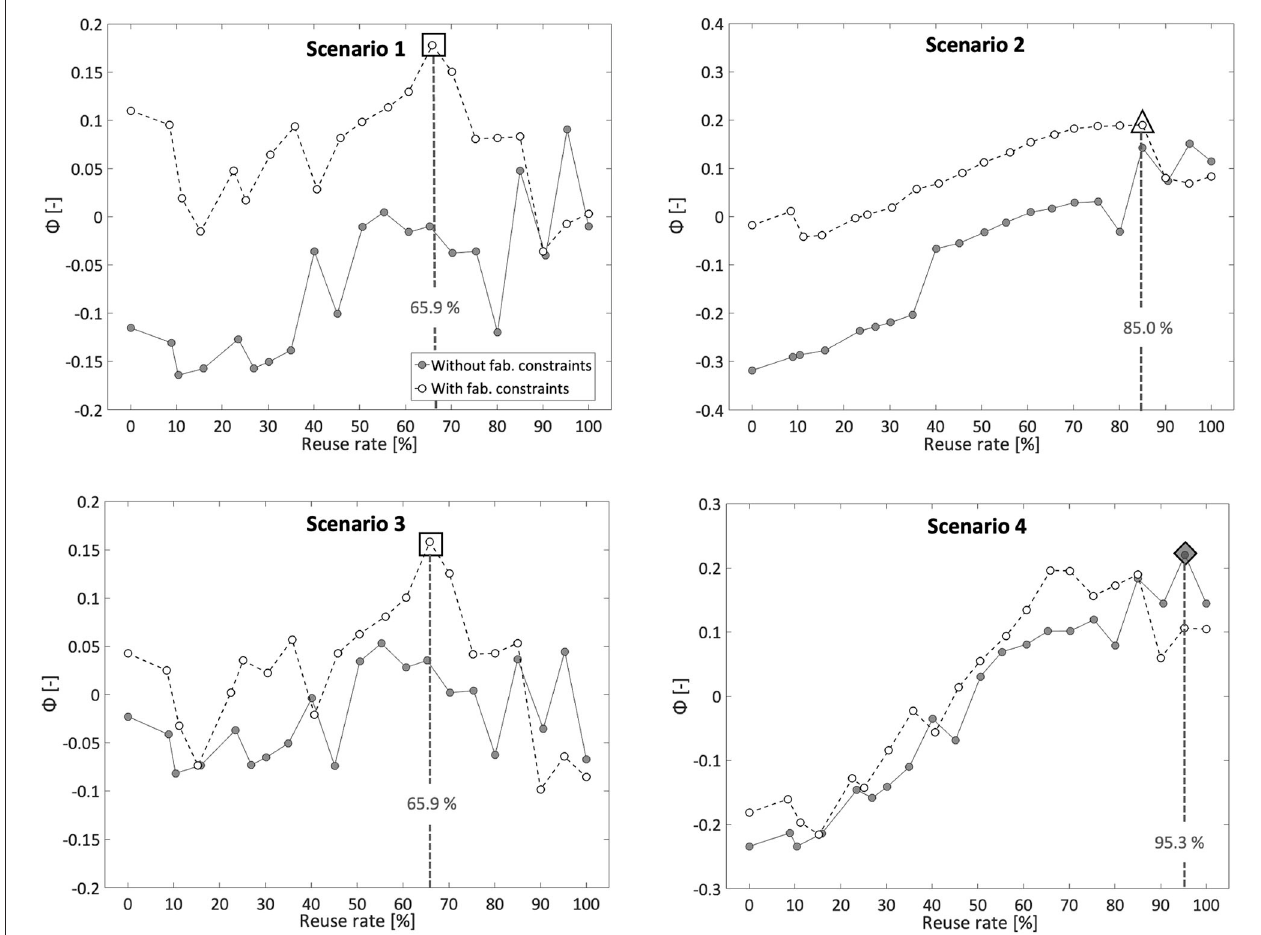
FIGURE 10 | PROMETHEE net flow ( Φ ) of design alternatives as a function of the reuse rate for the four